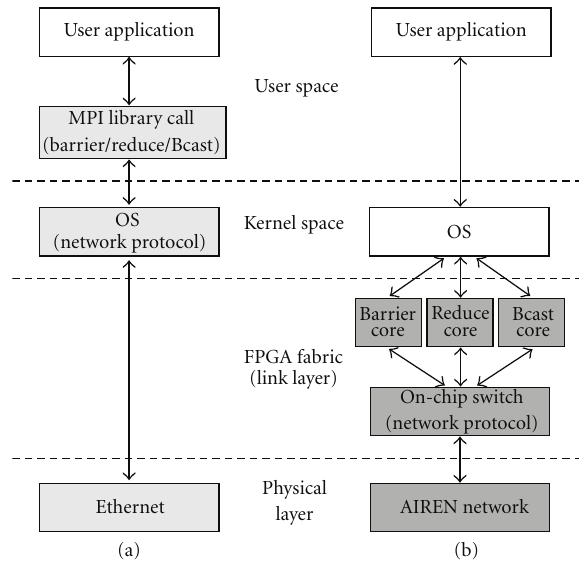
Figure 7: Example of system software refactored into hardware.